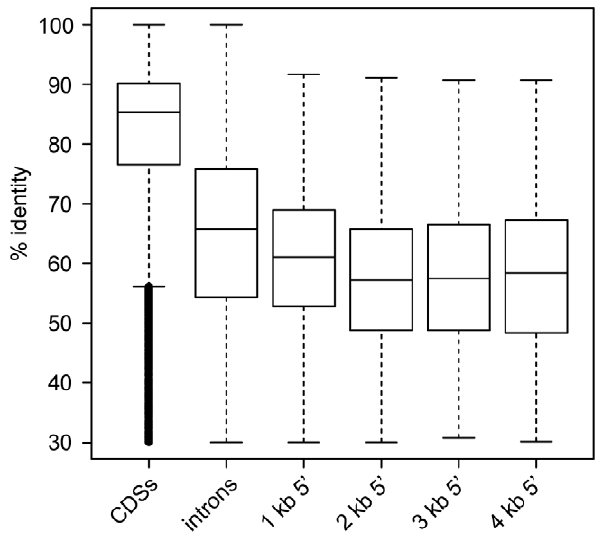
Figure 3. Pairwise identity between S.macrospora and N.crassa for different genomic regions. CDSs, introns, and regions upstream of CDSs (in 1 kb steps ranging from 1 to 4 kb) were used for comparison. Only those upstream regions were used that do not overlap with a protein coding region. Each region was used only once even if it is upstream of two divergently transcribed genes to avoid double-counting. The box plots show the distribution of % pairwise identities with the median value as a horizontal line in the box between the first and third quartiles. Detailed information on the comparisons can be found in Figure S4 and Table